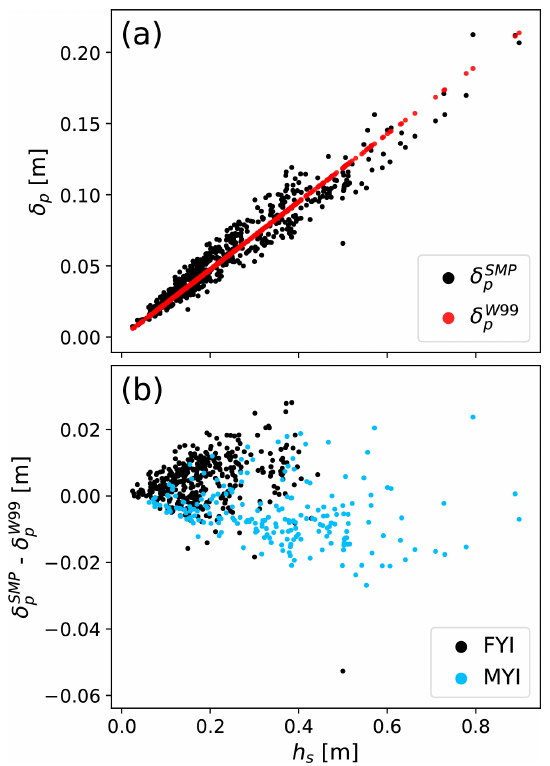
Figure 11. Changes in estimated radar propagation bias ( δ p ), (a) rel- ative to snow thickness ( h s ) based on density estimated from cli- matology ( δ w99 p ) and measured from SMP profiles ( δ SMP p ). The two sets of estimates were subtracted to show potential errors associated with the use of climatology over known snow densities (b)